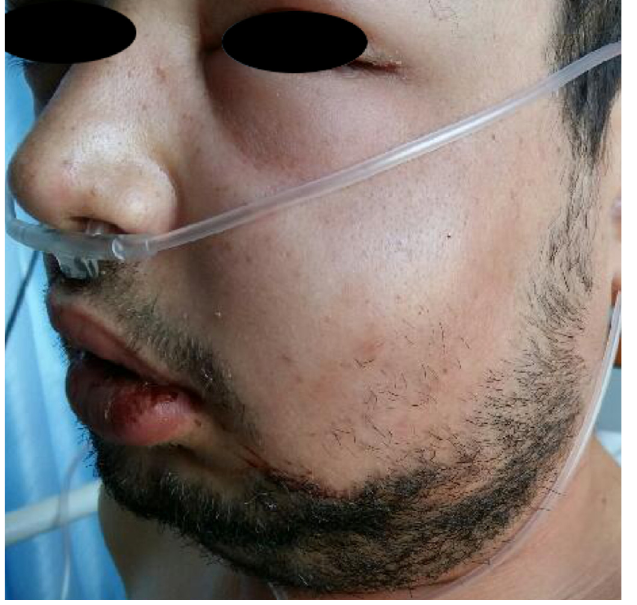
Fig. 2. Clinical aspect at D1 of fi rst procedure.